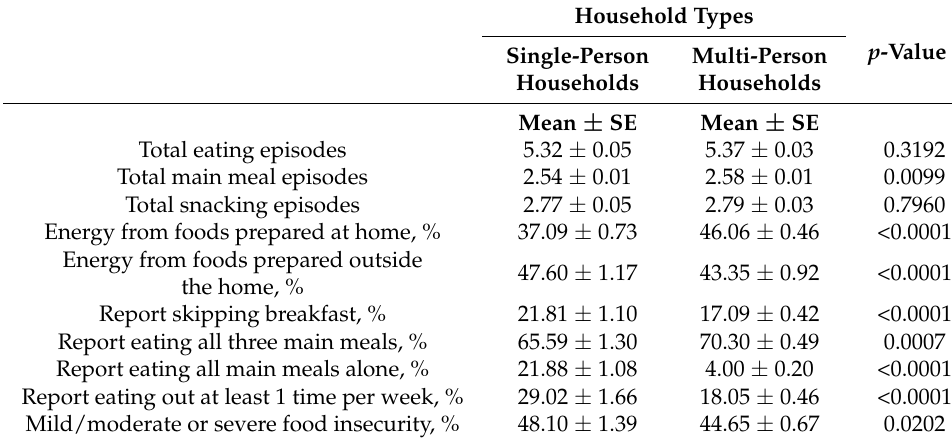
Table 4. Dietary behaviors among Korean adults according to household type based on 24-h dietary